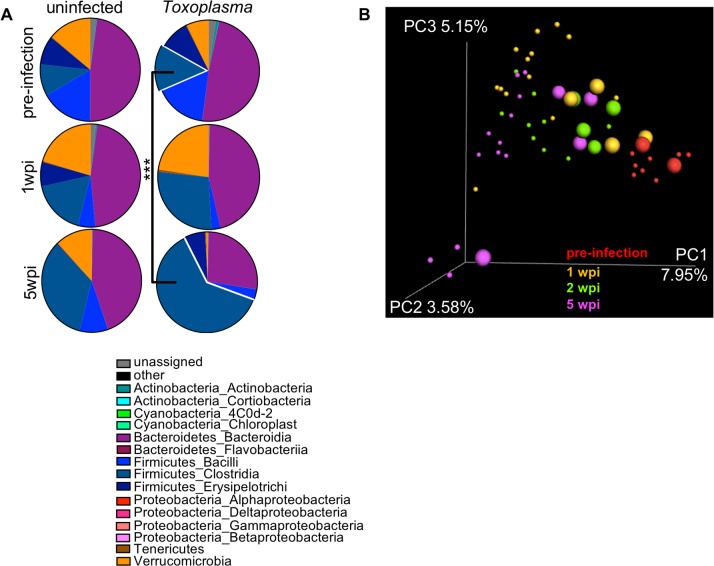
Changes in the commensal community are amplified in chronic infection.16S profiling of commensal microbiota in fecal pellets gathered 2 days before infection (pre-infection), 1wpi or 5wpi with 120 Toxoplasma cysts. A, At chronic infection there is a significant outgrowth of Firmicutes Clostridia in comparison to pre-infection (navy blue, outset). Toxoplasma infected group: pre-infection mean 0.147±0.015 SEM, 5wpi mean 0.599±0.142 SEM, ***p≤0.001 student’s T-test. Data represented as the mean of 3–8 mice per time point. B, Unweighted Unifrac principle component analysis of 16S ribosomal subunit diversity in the fecal pellets of mice 2 days before infection (pre-infection, red), 1 wpi (orange), 2 wpi (green) or 5 wpi (magenta). Small circles = infected, large circles = uninfected. Data representative of two experiments.